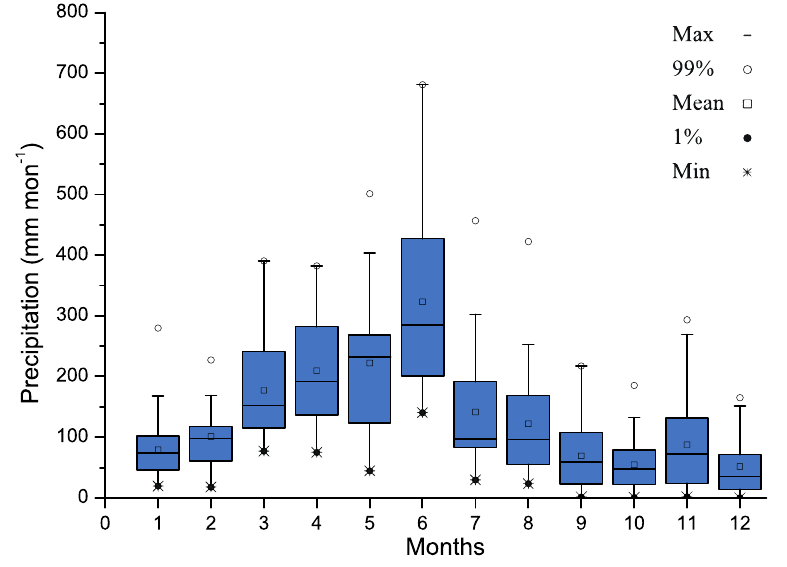
Figure 2. Seasonal variation of precipitation in Nanchang. 170